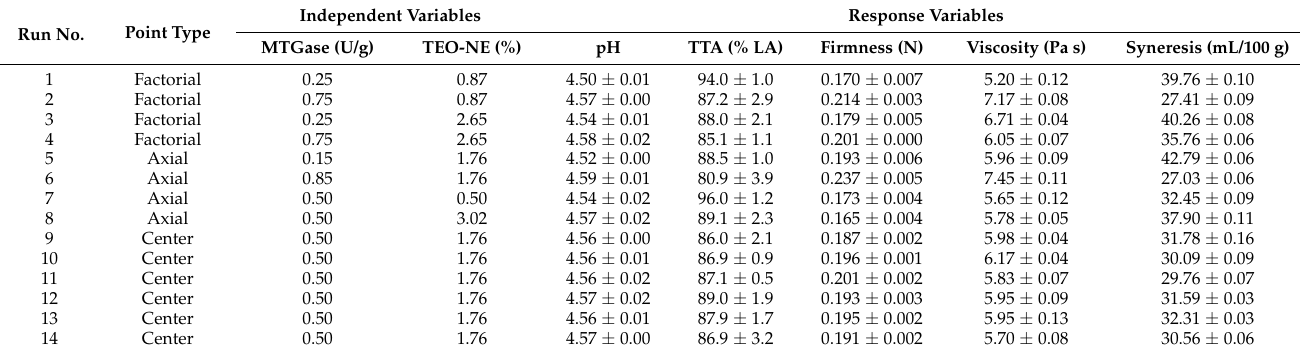
Table 3. Experimental design matrix for CCRD-RSM and actual